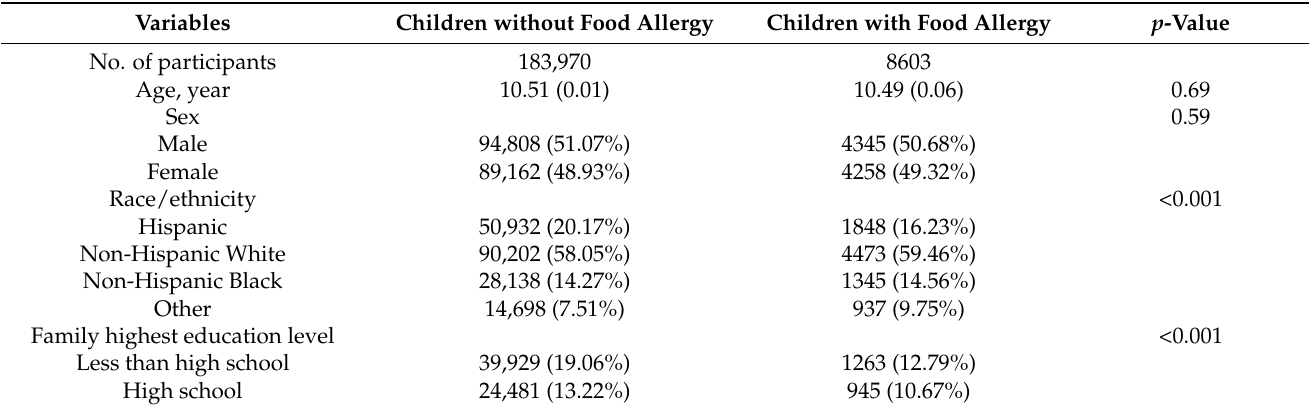
Table 1. Characteristics of the participants ( n = 192,573), according to food allergy